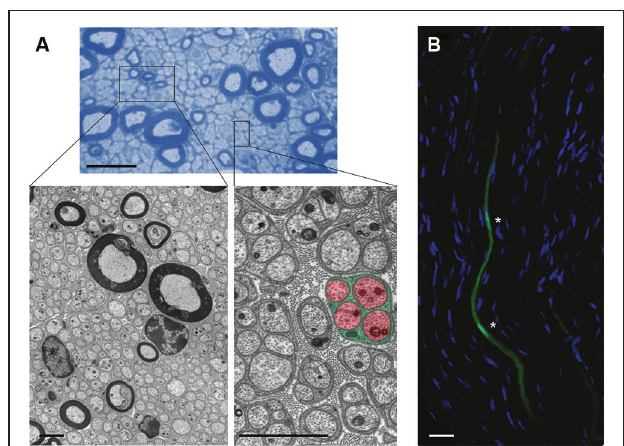
FIGURE 1 | Cytoarchitecture of EG and associated axons in mouse nerves. (A) (Upper): Semithin microscopy of transverse section through mouse vagus nerve in which more than 90% of all fibers are unmyelinated and form multiple Remak bundles. Scale bar: 10 µ m. Boxed areas from semithin preparation show electron micrographs (Lower) at different magnifications with characteristic cytoarchitecture of unmyelinating and myelinating SCs with their enwrapped axons. Note the tight association between glial processes (green) that interdigitate four unmyelinated small-caliber axons (red) in the highlighted Remak bundle from the right inset. Individual Remak bundles are surrounded by basement membranes and collagen fibers. Axonal and glial mitochondria are characterized by electron-dense appearance. Granular material within axons represents microtubules and neurofilaments. Scale bars: 2 µ m. (B) Fluorescence confocal microscopy of longitudinal section through mouse tibial nerve (nuclear counterstain with 4’,6-Diamidino-2-Phenylindole (DAPI)) in which two adjacent SC bodies (green) are genetically labeled with green fluorescent protein (GFP). Asterisks depict nuclear regions of SCs with their elongated bodies. Scale bar: 5 µ